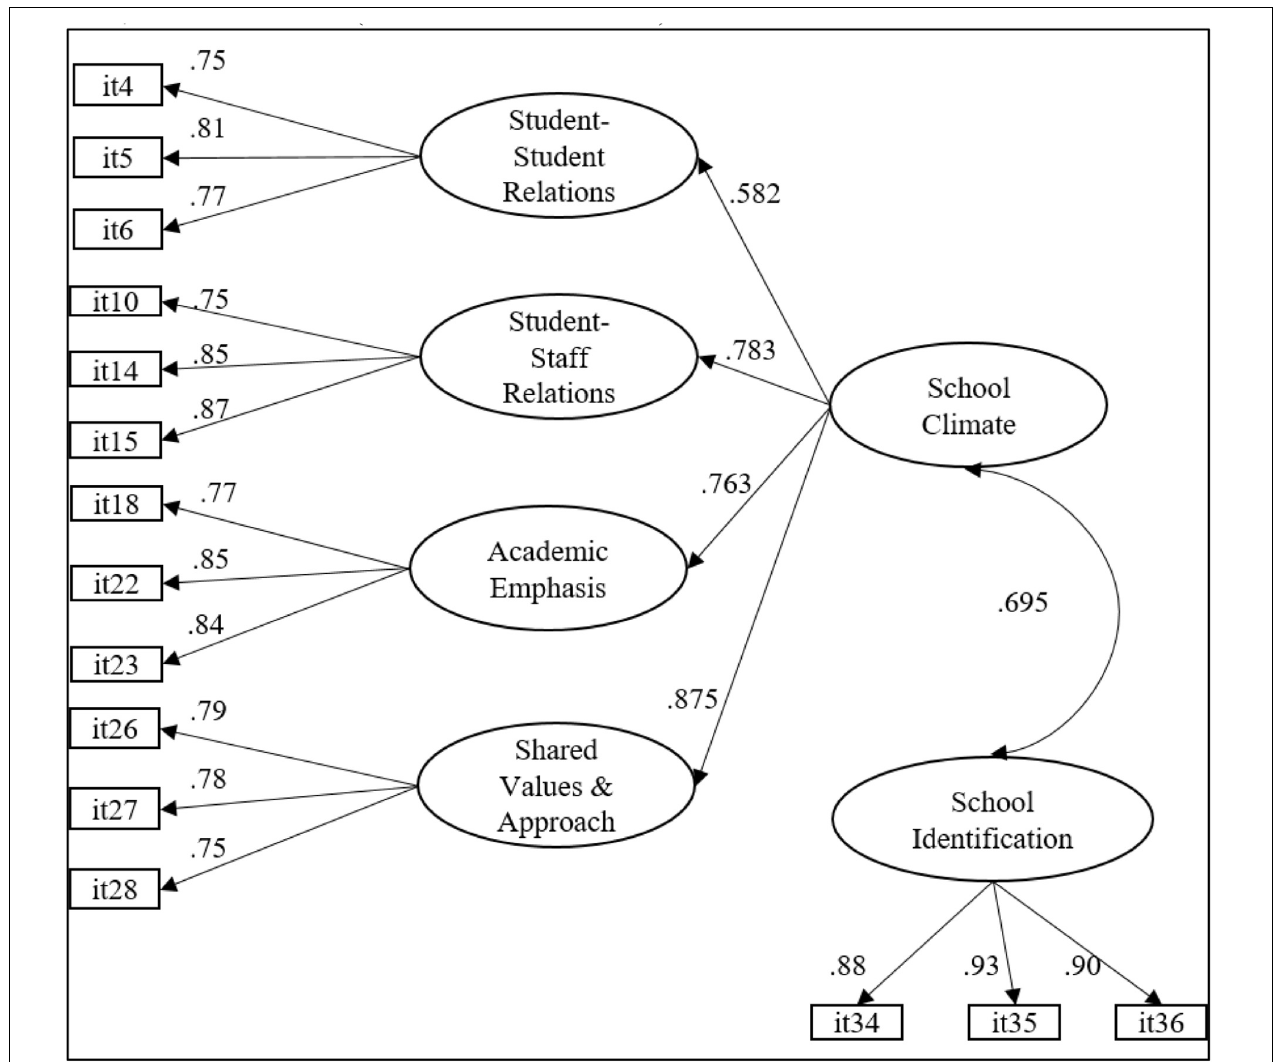
FIGURE 1 | The factorial structure of the abbreviated SCASIM-St. All estimated parameters were statistically significant ( p <